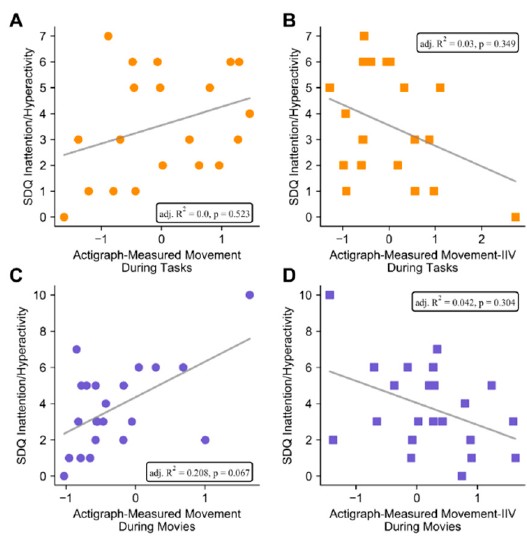
Figure 1. Associations between actigraph measurements and parent-rated attention-deficit / hyperactivity disorder (ADHD) symptoms. During cognitive testing, neither actigraph-measured movement ( A ) nor actigraph-measured movement IIV ( B ) were associated with parent-rated ADHD symptoms. Actigraph-measured movement during movies was positively associated with ADHD symptoms, though this association became marginal after adjusting for age and testing site ( C ). Actigraph-measured movement IIV trended towards being negatively associated with ADHD symptoms, but this association was non-significant after adjustment for age and testing site ( D ). Lines represent least-squares fit, while insets show adjusted R 2 and p values for multiple regressions after adjustment for age and testing site.